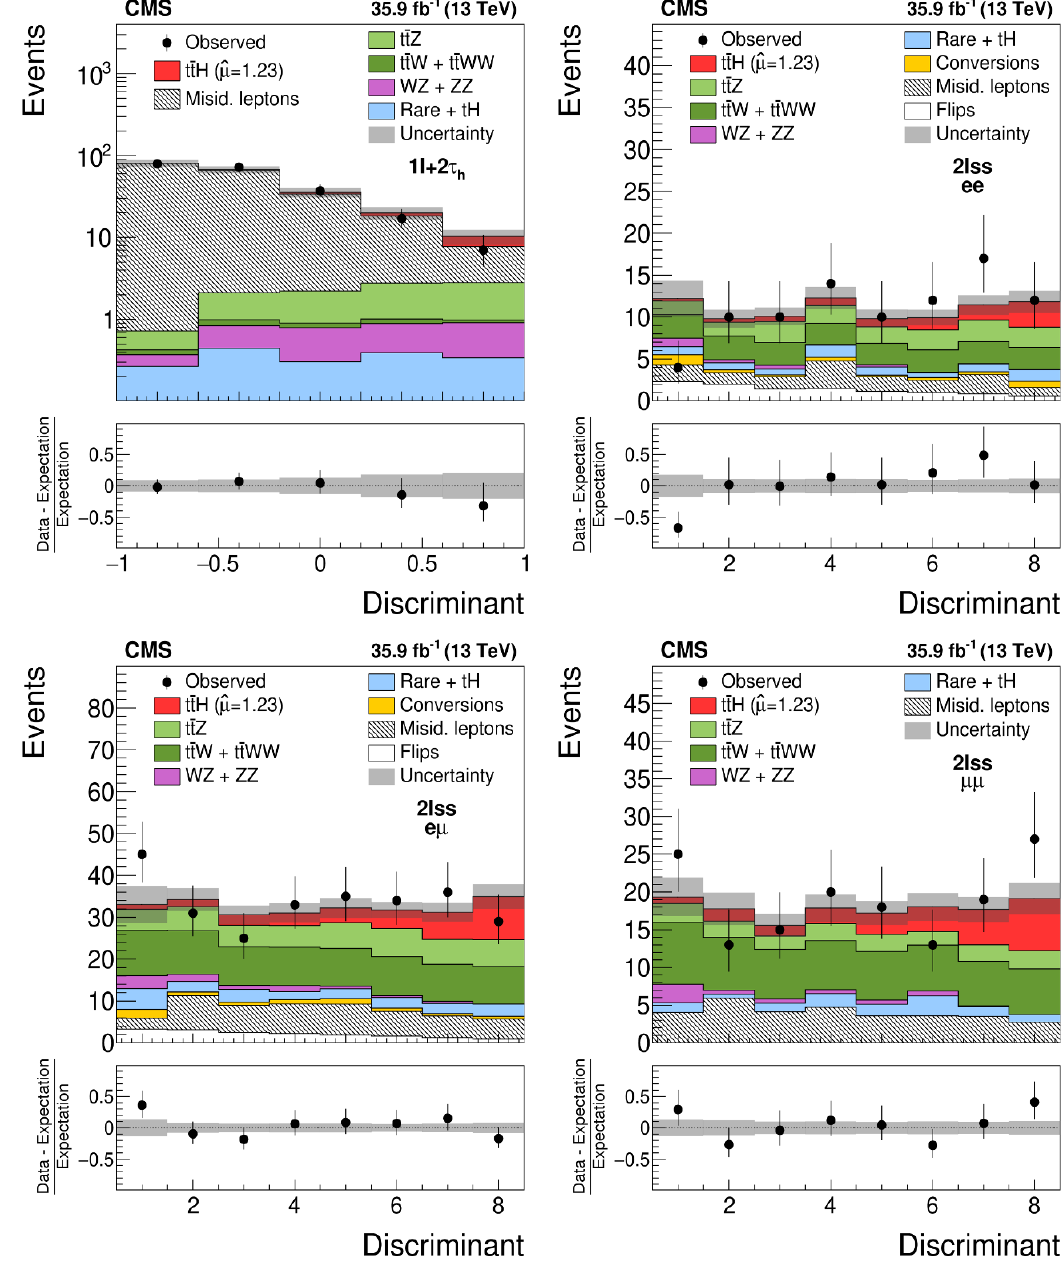
Figure 2 . Distributions in the discriminating observables used for the signal extraction in the 1 ‘ +2 (cid:28) h category (top left) and in di(cid:11)erent subcategories of the 2 ‘ ss category (top right and bottom row), compared to the SM expectation for the ttH signal and for background processes. A BDT trained to separate the ttH signal from the tt+jets background is used in the 1 ‘ +2 (cid:28) h category, while a D MVA variable, combining the outputs of two BDTs trained to discriminate the ttH signal from the ttV and tt+jets backgrounds respectively, is used in the 2 ‘ ss subcategories. The distributions expected for signal and background processes are shown for the values of nuisance parameters obtained from the combined ML (cid:12)t and (cid:22) = ^ (cid:22) = 1 : 23, corresponding to the best-(cid:12)t value from the ML (cid:12)t.